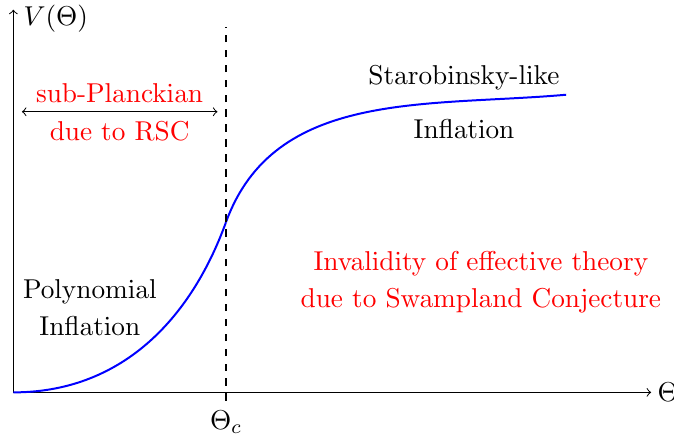
Figure 3 . The plot depicts schematically a typical potential V ((cid:2)) for an in(cid:13)aton (cid:2) achieved via axion monodromy. Above some critical value (cid:2) c the backreaction of the in(cid:13)aton onto the other moduli deforms the polynomial potential to a Starobinsky-like plateau. However, in this regime the e(cid:11)ective theory breaks down according to the swampland conjecture. The re(cid:12)ned version of the con- jecture (RSC) sets (cid:2) c (cid:24) 1, reducing the controllable in(cid:13)aton (cid:12)eld range to sub-Planckian